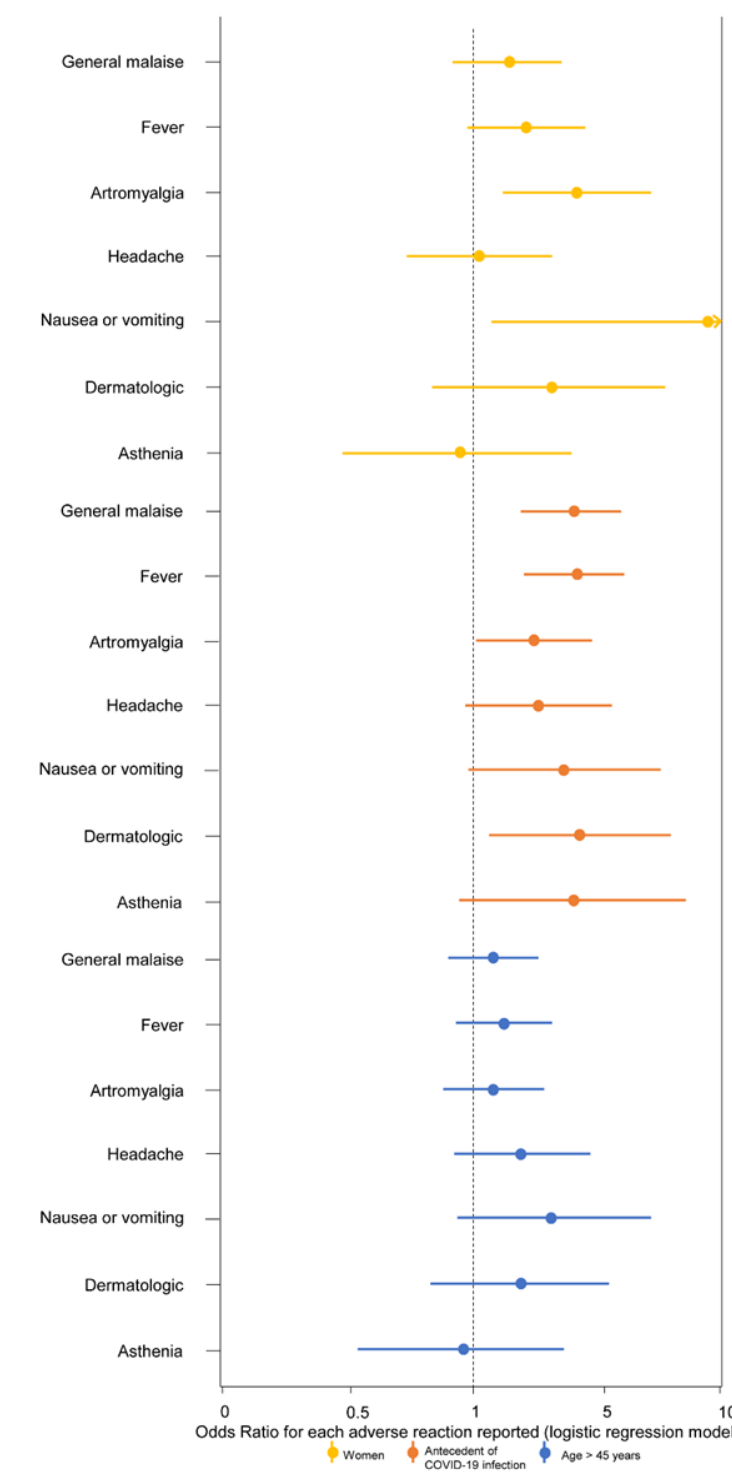
Figure 1. Associations of female sex, antecedent COVID-19 infection, and age >45 years with the most frequent adverse reactions after BNT162b2 vaccine in hospital workers. Odds Ratios are presented with 95% confidence interval for each outcome (specific symptom). The reference categories were men, no antecedent COVID-19 infection, and age ≤ 45 years, respectively.